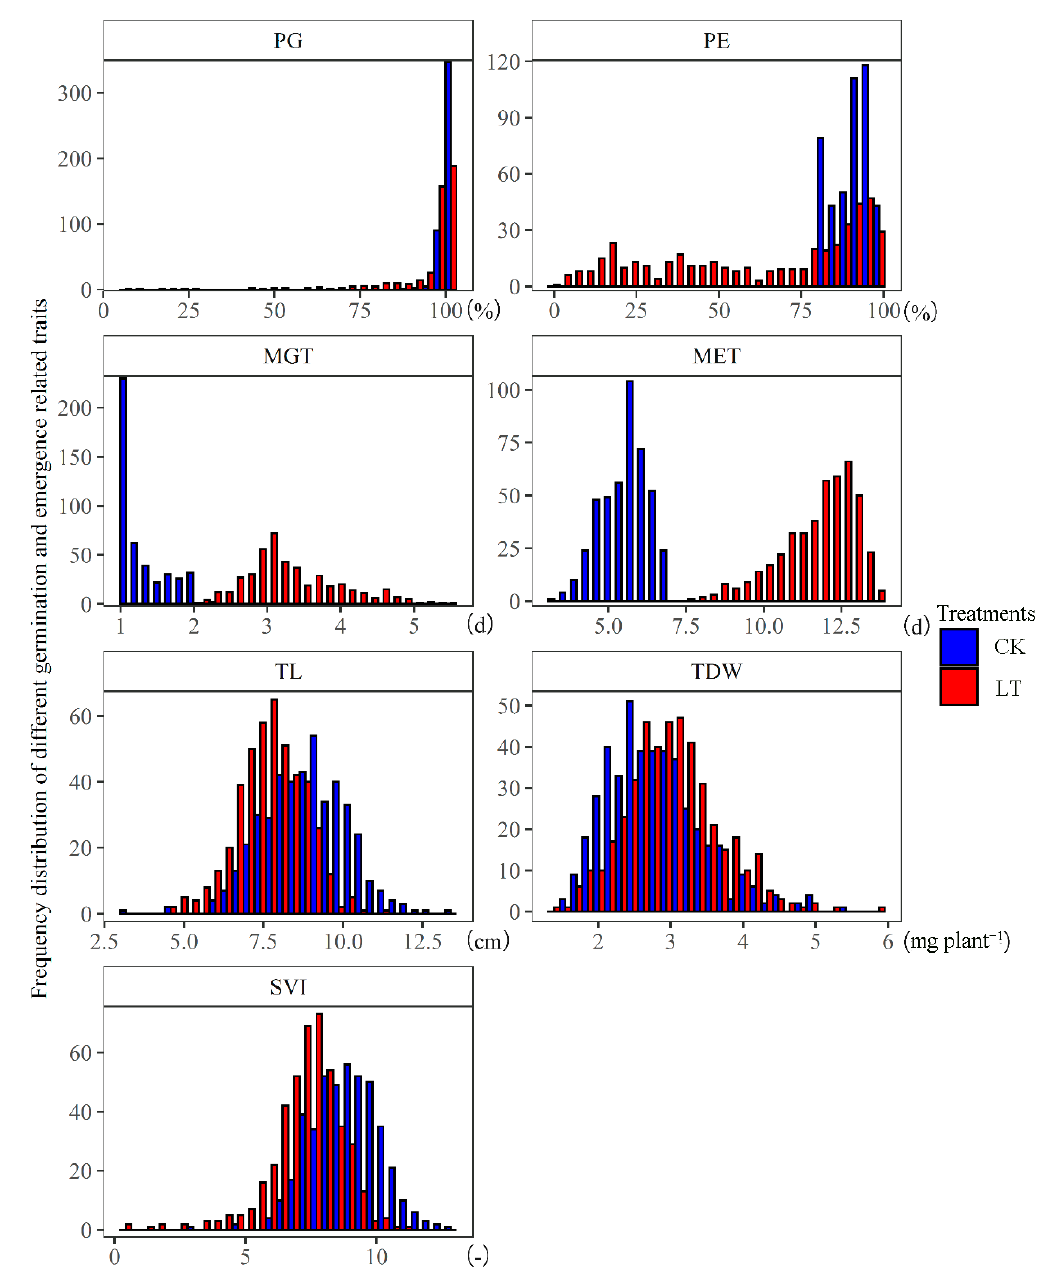
Figure 2. Frequency distribution of functional traits related to seed germination and seedling emergence under normal- (CK) and low-temperature (LT) conditions for 436 rapeseed lines. PG, percentage of germination; PE, percentage of emergence; MGT, mean germination time; MET, mean emergence time; TL, total seedling length; TDW, total dry weight; SVI, seedling vigor index.